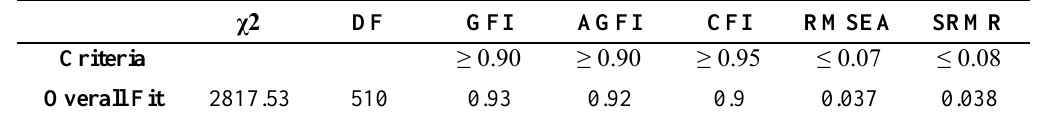
Table.5. Goodness of Model